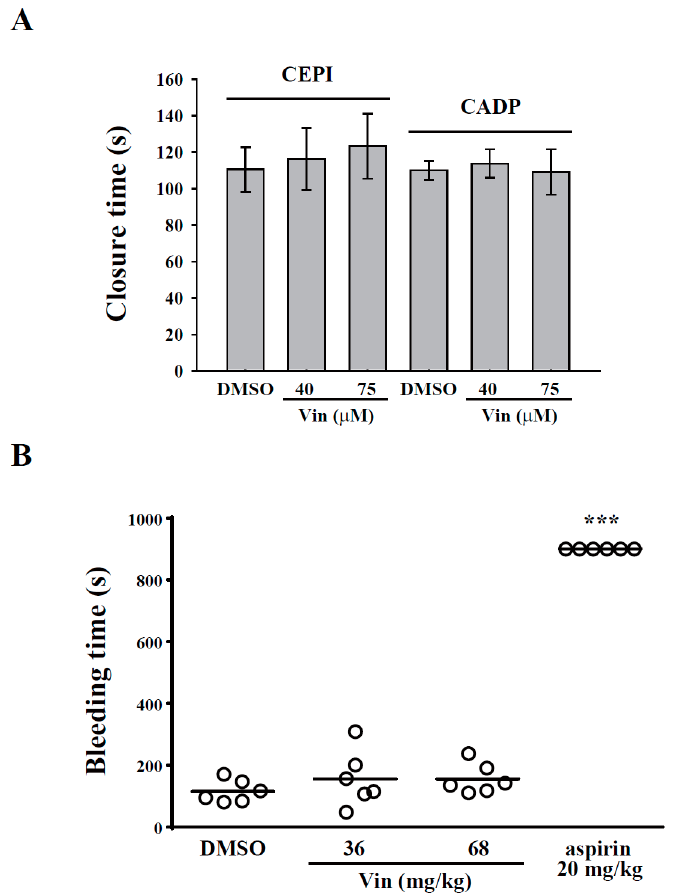
Figure 6. Effects of vincristine on in vitro and in vivo hemostasis. ( A ) Whole blood sample was collected in collagen/epinephrine or collagen/ADP and treated with DMSO and vincristine (40 and 70 μ M). Closure time was then measured by platelet function analyzer-100 assay. ( B ) Mice were intravenously administered DMSO (solvent control), vincristine (36 and 68 mg/kg), or aspirin (20 mg/kg, positive control) for 10 min. Tail bleeding was induced by cutting the tail, and the bleeding time was recorded until the time when no sign of bleeding was observed for at least 10 s. Each point in the plot indicates one mouse ( n = 6). Data in ( B ) are presented as the mean ± standard error of the mean ( n = 6). *** P < 0.001 compared with the DMSO group.